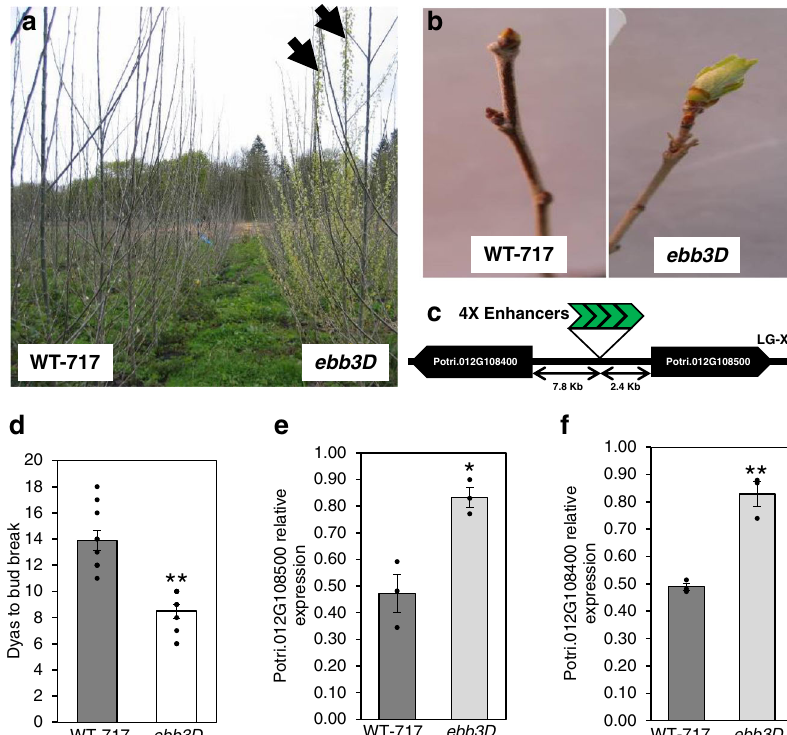
Fig. 1 Isolation and molecular analysis of the early bud-break 3D ( ebb3D ) poplar mutant. a ebb3D poplar mutant plants show early bud-break in the fi eld during the start of the second growing season as compared to neighboring WT-717 control trees, arrows point to two ebb3D ramets that show early bud- break compared to the WT-717 plants and other neighboring activation tagging events. b Early bud-break in ebb3D mutant plant as compared to WT-717 under controlled growth chamber conditions (see Methods for more details). c Genome position of the activation tag insertion in the ebb3D mutant, 4X enhancers derived from the CaMV35S promoter. d The average number of days to bud-break in WT-717 and ebb3D mutant plants. e , f Potri.012G108400 and Potri.012G108500 genes are upregulated in the ebb3D mutant. Expression values are the average of three biological replicates ±SEM, normalized to the reference ACT7 gene. At least 10 plants of the ebb3D mutant and WT-717 genotypes were used in the bud-break analysis. Asterisks (*) and (**) indicate signi fi cant differences at P < 0.02 and P < 0.002 compared to WT-717 control plants by two-tailed paired t -tests. Source data underlying Fig. 1a – d are provided as a Source Data fi